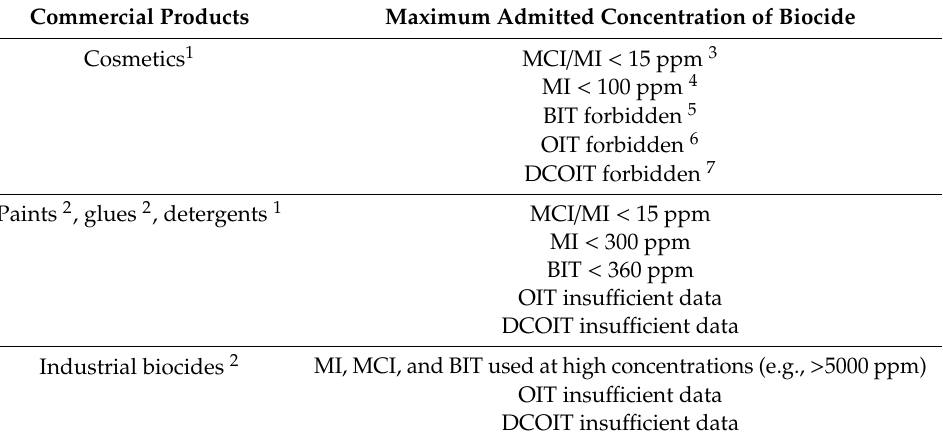
Table 4. Maximum concentration of isothiazolinones admitted in commercial products available in the EU